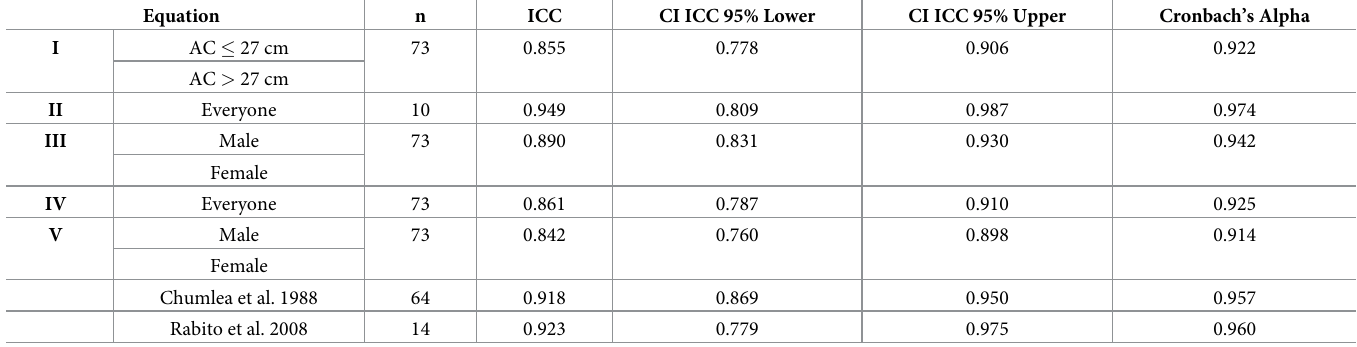
Table 5. Analysis of the agreement of the estimated weight of the developed model with the observed and estimated weights using the equations proposed by Chum- lea et al. (1988) and Rabito et al. (2008). Equation n ICC CI ICC 95%